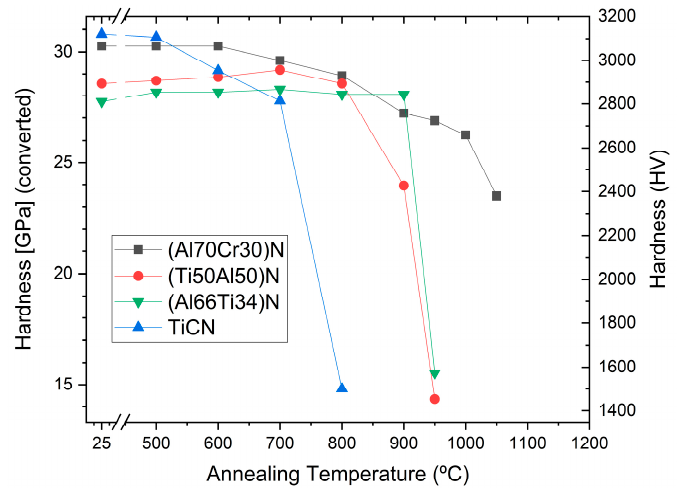
Figure 12. Hardness after annealing of commercial TiCN, (Ti 50 Al 50 )N, (Al 66 Ti 34 )N and (Al 70 Cr 30 )N coatings on cemented